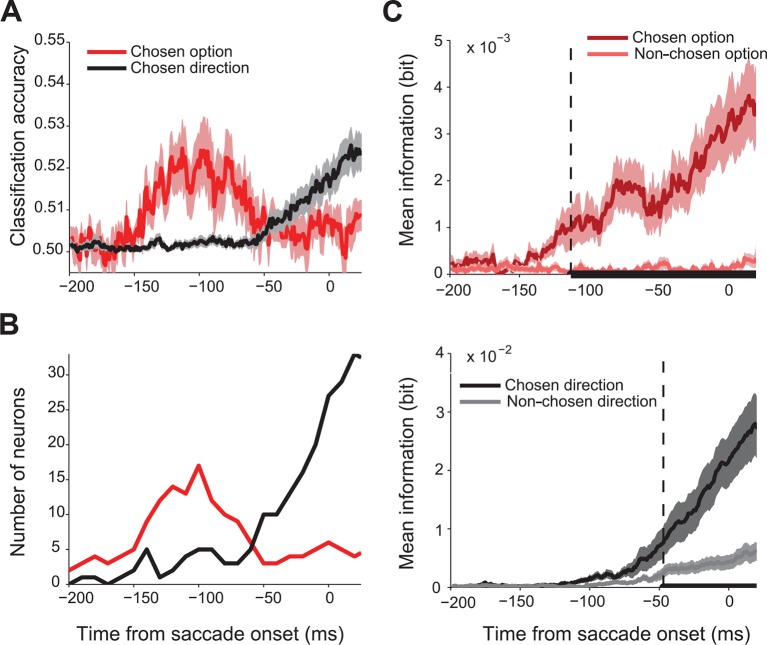
Time course of chosen gamble option and saccade direction representation in SEF.(A) Significant classification accuracy for chosen gamble option (red) and chosen saccade direction (black) across 128 neurons. We excluded values that were not significantly different from chance (permutation test; p≤0.05). (B) Number of neurons showing significant classification accuracy for chosen gamble option (red) and chosen saccade direction (black). (C) Average mutual information between SEF activity and chosen and non-chosen gamble option (top panel; dark and light red) and saccade direction (bottom panel; dark and light grey). The time period when the amount of information about chosen and non-chosen option/direction was significantly different (paired t-test adjusted for multiple comparisons, p≤0.05) are indicated by the thick black line at the bottom of the plots. The onset of a significant difference is indicated by the vertical dashed line. SEF, supplementary eye field.